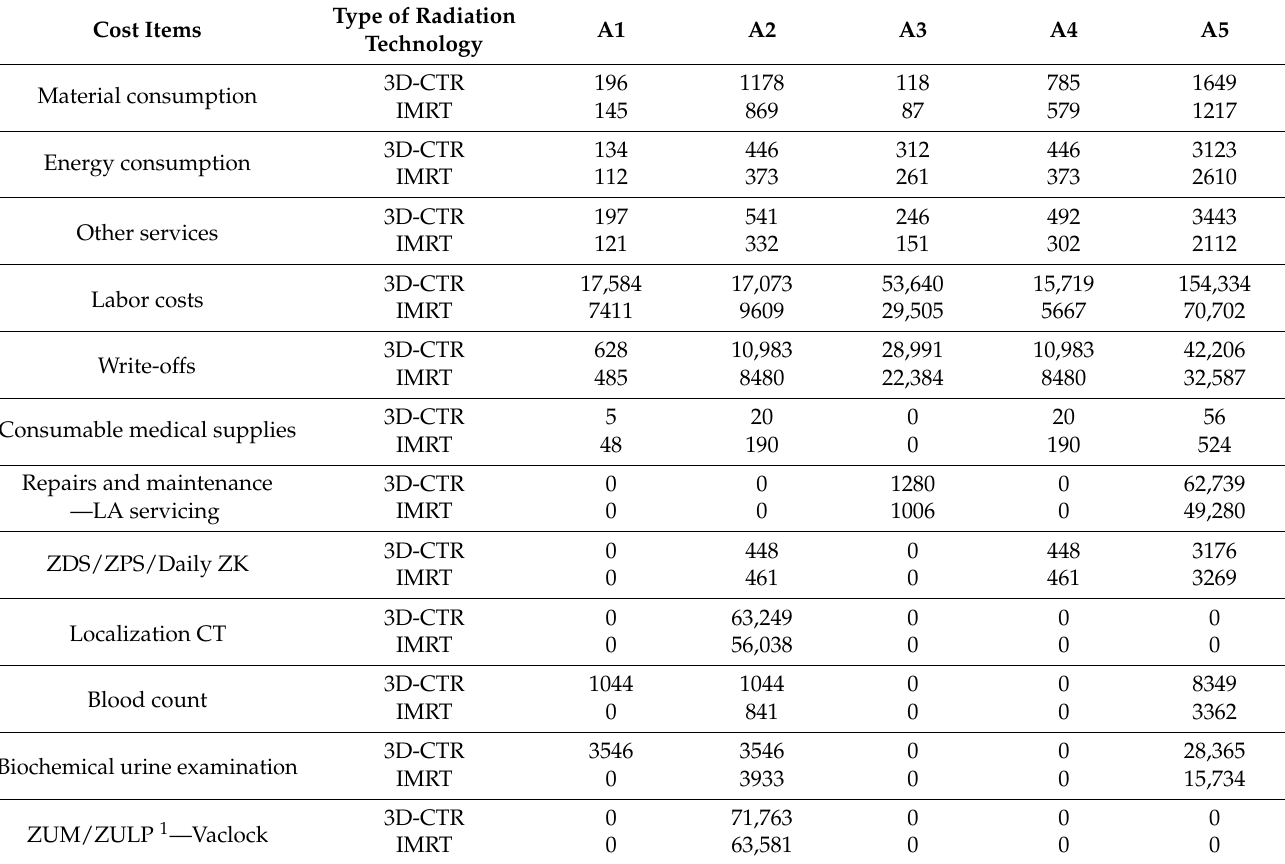
Table 10. 3D-CRT and Intensity Modulated Radiation Therapy (IMRT) technology costs matrix (EUR).